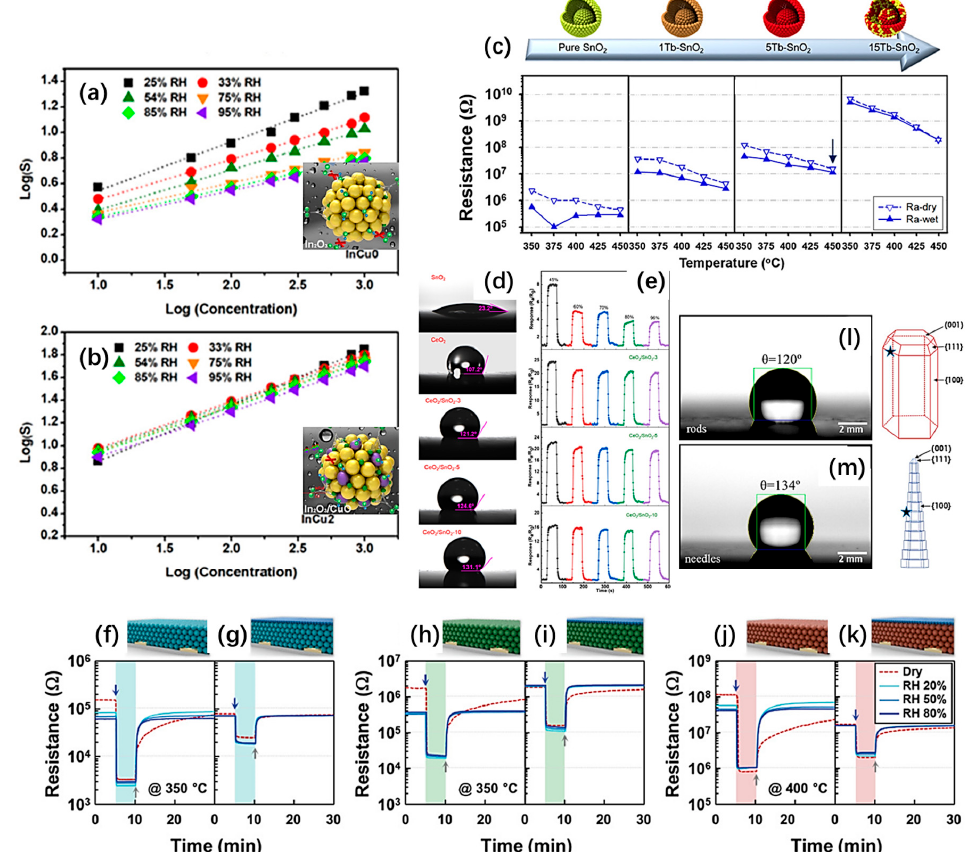
Figure 8. Improving the humidity resistance of MOS. Dynamic response and relationship between response and concentration under diverse humidity for ( a ) InCu 0 and ( b ) InCu 2 . ( c ) Resistances of the pure SnO 2 , 1Tb-SnO 2 , 5Tb-SnO 2 , and 15Tb-SnO 2 sensors under dry and 80% RH conditions. ( d ) Static water contact angle tests of SnO 2 , CeO 2 , and CeO 2 /SnO 2 films. ( e ) Responses of SnO 2 , CeO 2 , and CeO 2 /SnO 2 films at different RHs. Responses of pure ( f ) In 2 O 3 , ( h ) SnO 2 , and ( j ) ZnO. Responses of ( g ) In 2 O 3 , ( i ) SnO 2 , and ( k ) ZnO with Tb 4 O 7 coverage layer. Static water contact angle tests of ( l ) rod-ZnO and ( m ) needle-ZnO. Panels ( a , b ): reproduced with permission from Ref. [137], © 2020 American Chemical Society. Panels ( c ): reproduced with permission from Ref. [131], © 2018 American Chemical Society. Panels ( d , e ): reproduced with permission from Ref. [139], © 2022 American Chemical Society. Panels ( f – k ): reproduced with permission from Ref. [140], © 2020 The Authors. Advanced Functional Materials published by Wiley-VCH GmbH. Panels ( l – m ): reproduced with permission from Ref. [142], © 2019 The Authors. Published by Elsevier